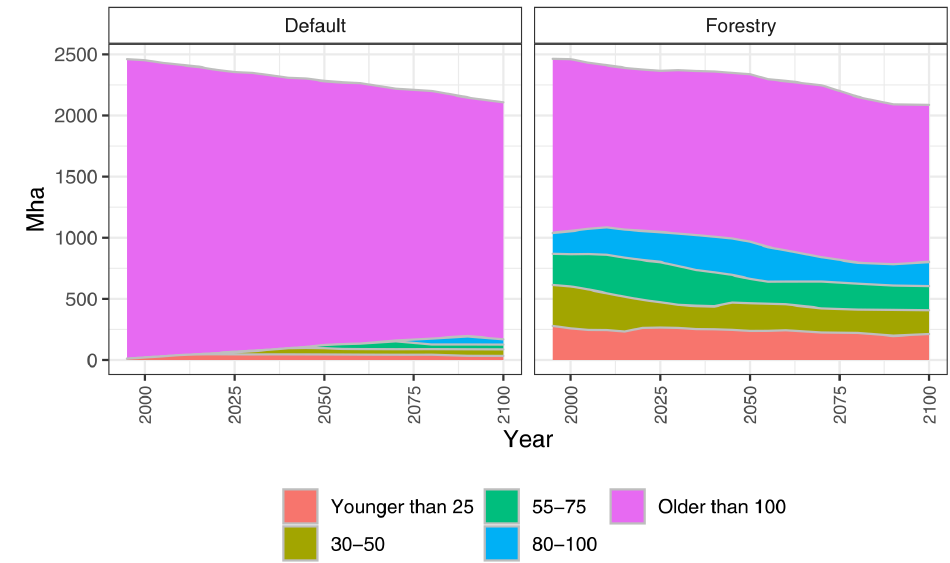
Figure 15. Age-class structure in secondary forest. The majority of secondary forest belongs to the highest age class,